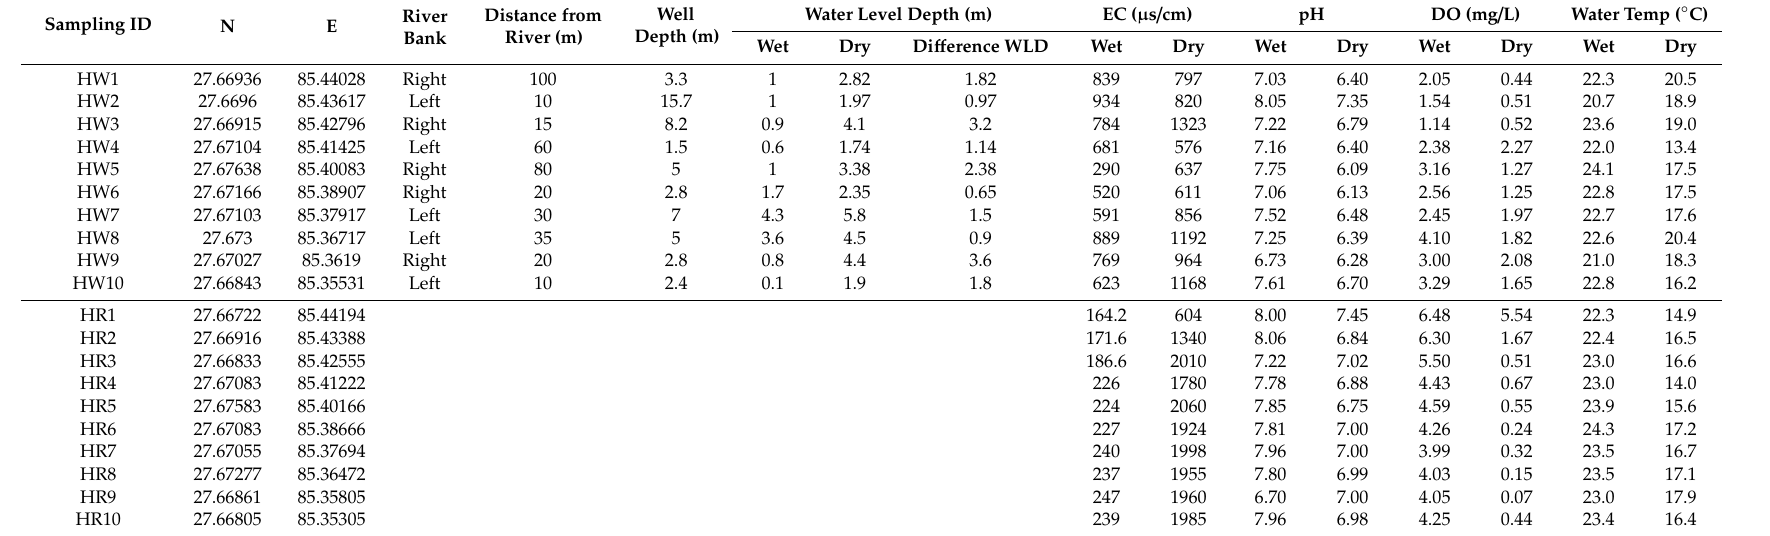
Table 1. In situ measured parameters of groundwater and river water in the wet (7 August 2017) and dry (18 February 2018) seasons. Sampling